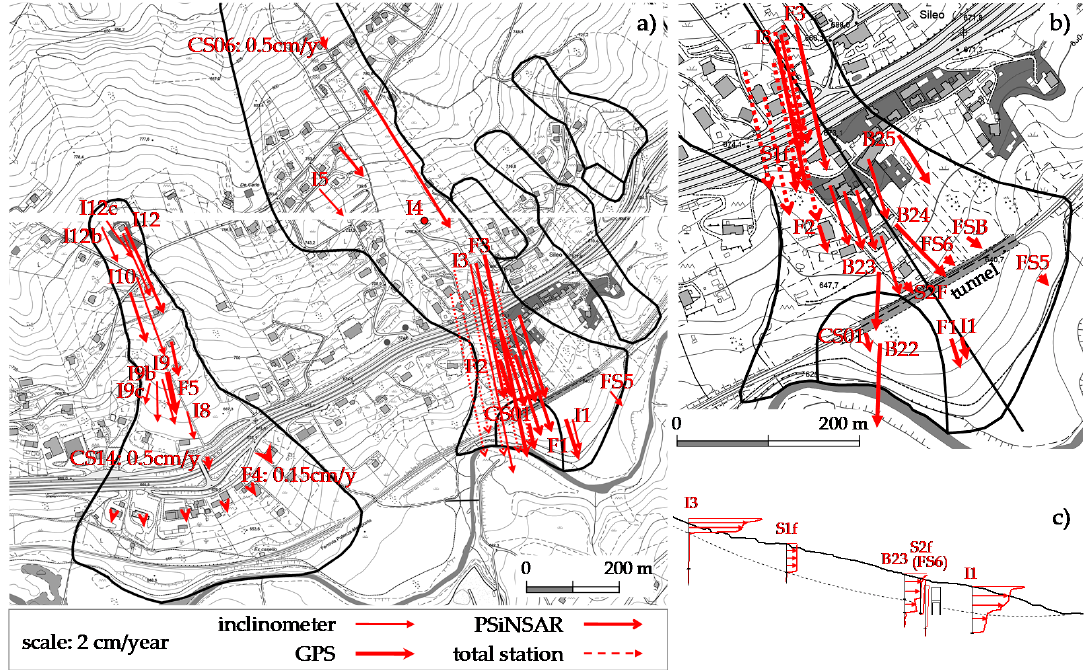
Figure 14. Vectors of average rates of horizontal displacements obtained from inclinometer, GPS, and PSInSAR data in the period May 2011–March 2014 and from topographic measurements carried out in 2010–2011 (a) ; zoom (b) and longitudinal section (c) of Varco d’Izzo earthflow accumulation.